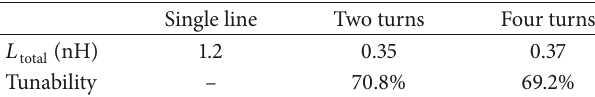
Table 1: Inductance and tunability of electrical model. Single line Two turns Four turns 𝐿 total (nH) 1.2 0.35 0.37 Tunability